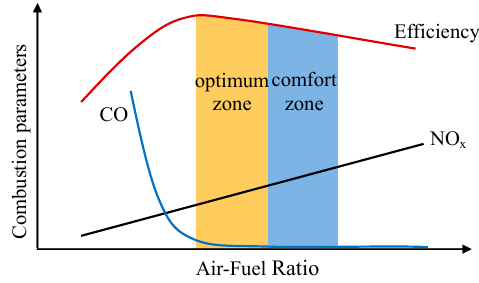
Figure 1. Emissions and efficiency as a function of air–fuel ratio.